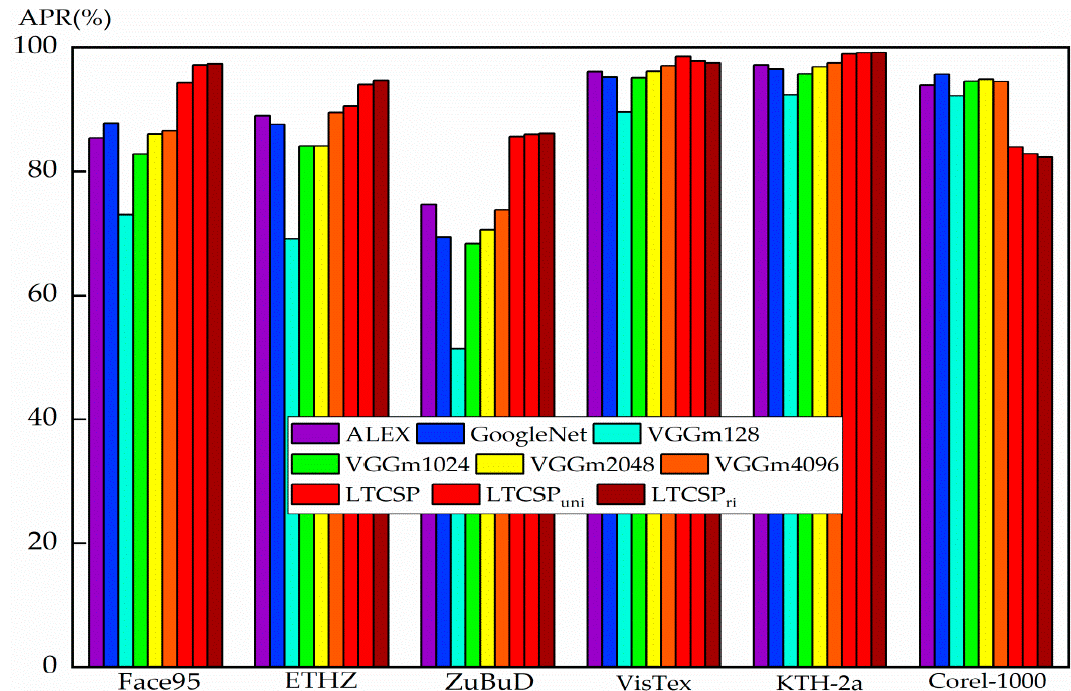
Figure 8. The comparisons of the APR rates among the proposed LTCSP, LTCSP uni and LTCSP ri descriptors and the emerging deep learning (DL)-based models on six datasets.